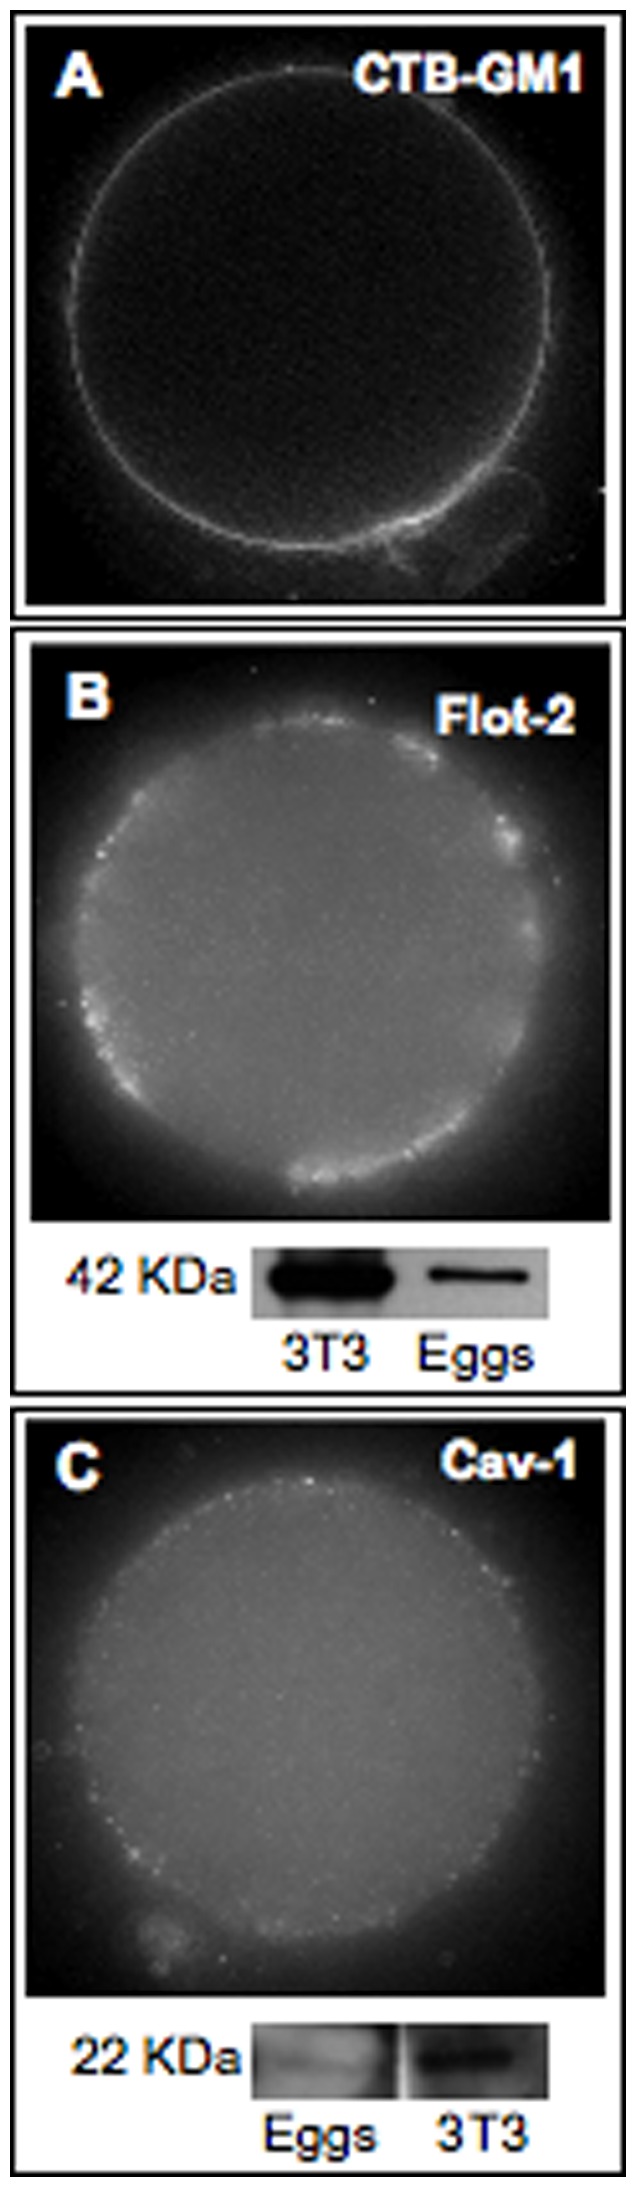
Presence of the raft markers GM1, Flotillin-2 and Caveolin-1 in the mouse oocyte.(A) Plasma membrane localization of the raft marker lipid GM1 assessed by incubation of living oocytes with CTB-AF488. (B) Indirect immunofluorescence detection in fixed oocytes and immunoblot detection in whole oocyte lysates of flotillin-2 and (C) caveolin-1. Fluorescence staining was performed in a total of 35 oocytes for GM1, 13 oocytes for flotillin-2 (Flot-2), and 10 oocytes for caveolin-1 (Cav-1). For the Western blots, numbers to the left of each panel indicate the molecular weight of the protein. A total of 120 (Flot-2) and 470 oocytes (Cav-1) were pooled and lysed. 3T3 cell lysates were used as positive controls.